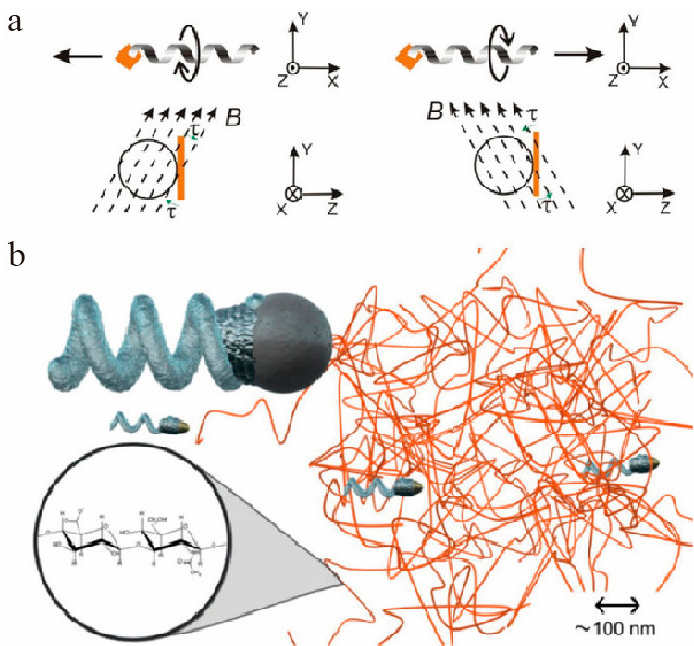
Figure 4. ( a ) Schematic diagram of movement of artificial bacterial flagella driven by rotating magnetic field. The figure has been reproduced with permission from the American Institute of Physics [17]. ( b ) Schematic diagram of artificial flagella moving in hyaluronan gels, which is driven by oscillating magnetic field. The figure has been reproduced with permission from the American Chemical Society [18].